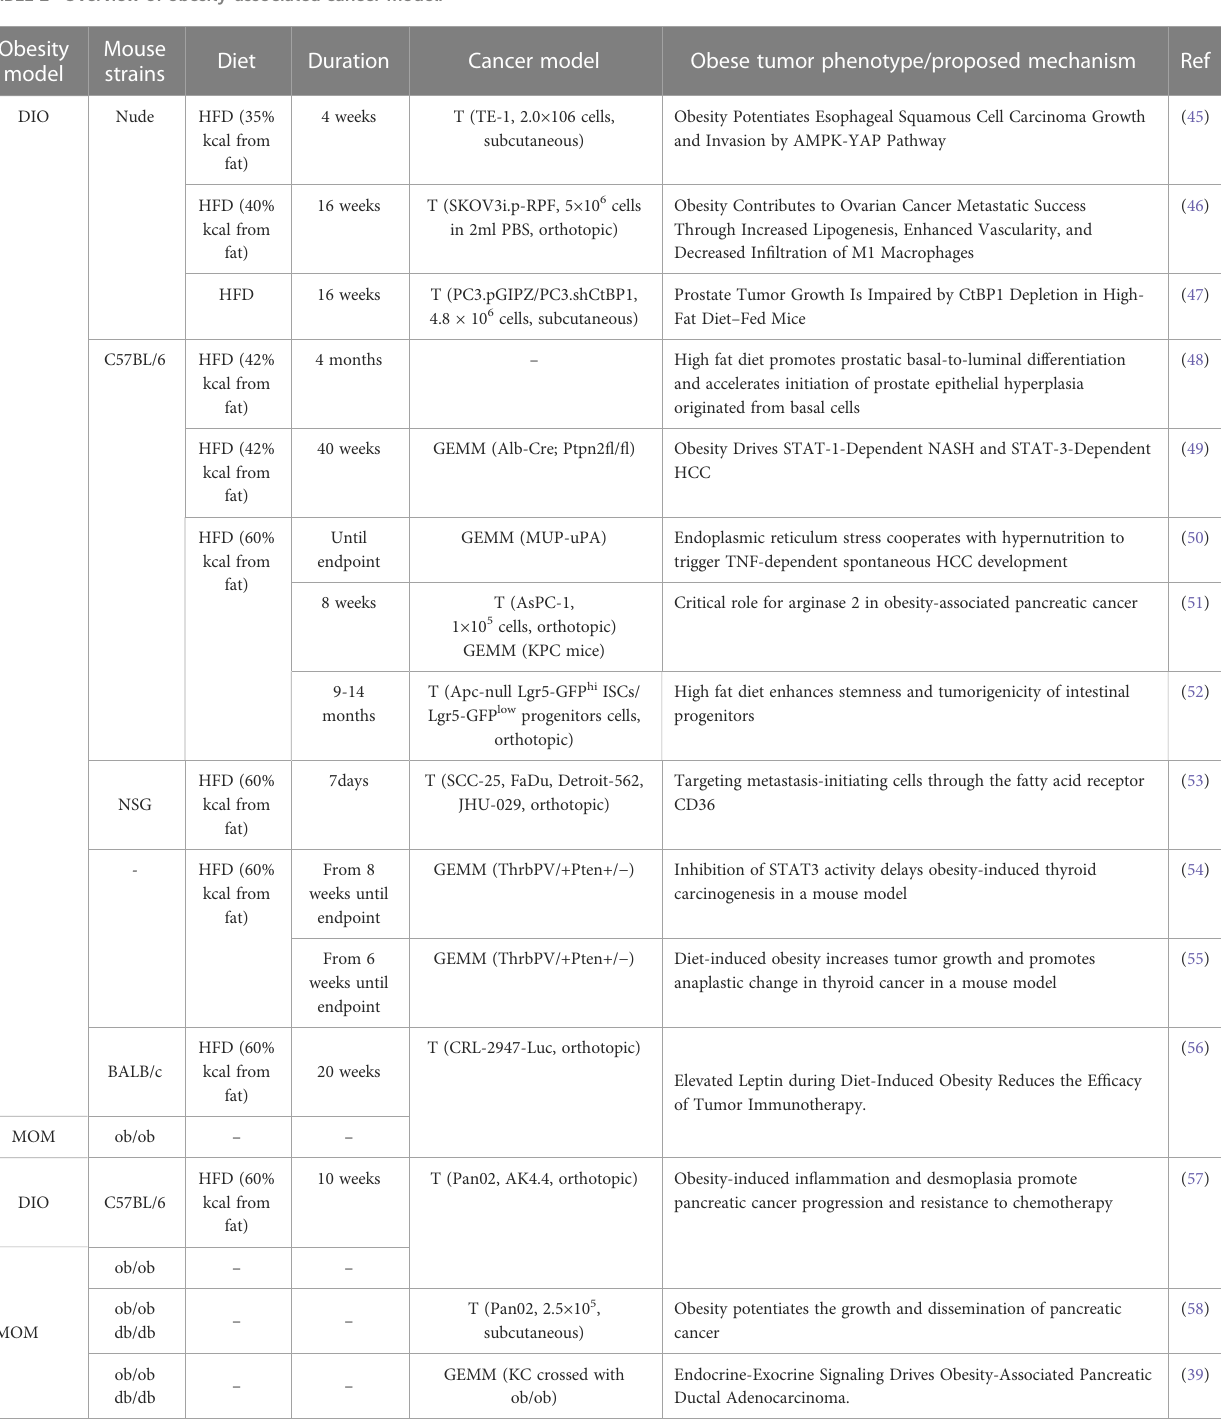
TABLE 2 Overview of obesity-associated cancer